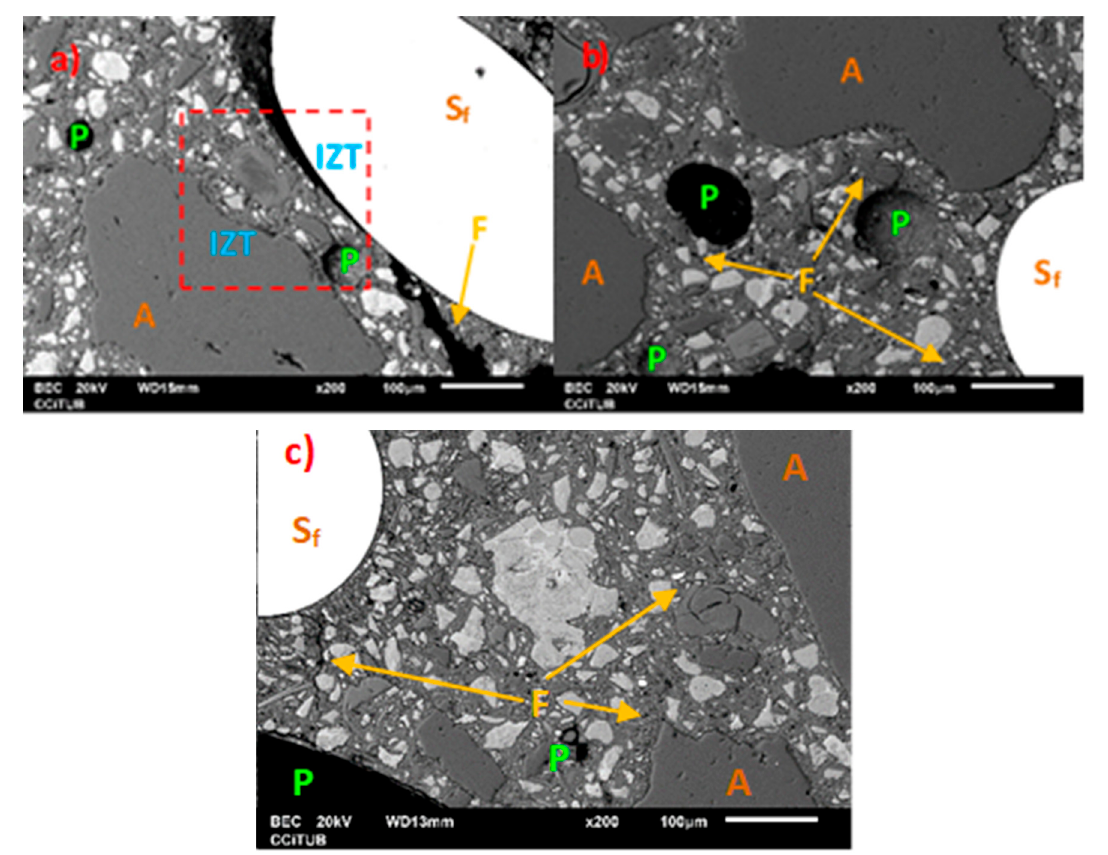
Figure 10. SEM-BEC images of reference concrete ( a ) with 70% ( b ) and 100% ( c ) granite waste; S f Steel fibre, P – pore, A – Aggregate, F – Fissure.